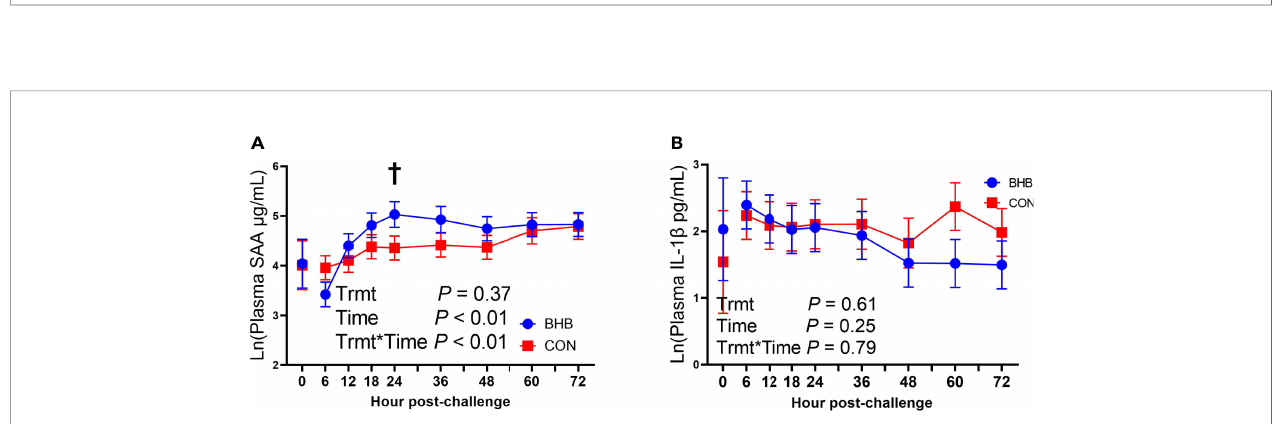
FIGURE 2 | Intravenous infusion of b -hydroxybutyrate impaired mammary gland defense during a Streptococcus uberis challenge. Late lactation, multiparous Holstein cows (n = 12) were blocked by parity and milk yield and randomly assigned to either receive an intravenous infusion of 2.5 M Na-BHB to induce hyperketonemia or 2.5 M NaCl (CON) for 72 h. Infusion rates were adjusted to maintain a target concentration of 1.8 mM BHB in the BHB-infused cows. All cows were challenged with S. uberis in the right rear and right front quarters of the mammary gland at the start of the infusion. Milk samples collected from the front challenged quarter were used for bacterial enumeration (A) , identi fi cation of clinical mastitis (B) , and somatic cell count (SCS; C ). Dry matter intake (D) and milk yield (E) were recorded daily. Vaginal temperature (F) was recorded hourly using a data logger and averaged by day. Data presented as LSM ± SE. * P ≤ 0.05, † 0.05 < P ≤ 0.10.